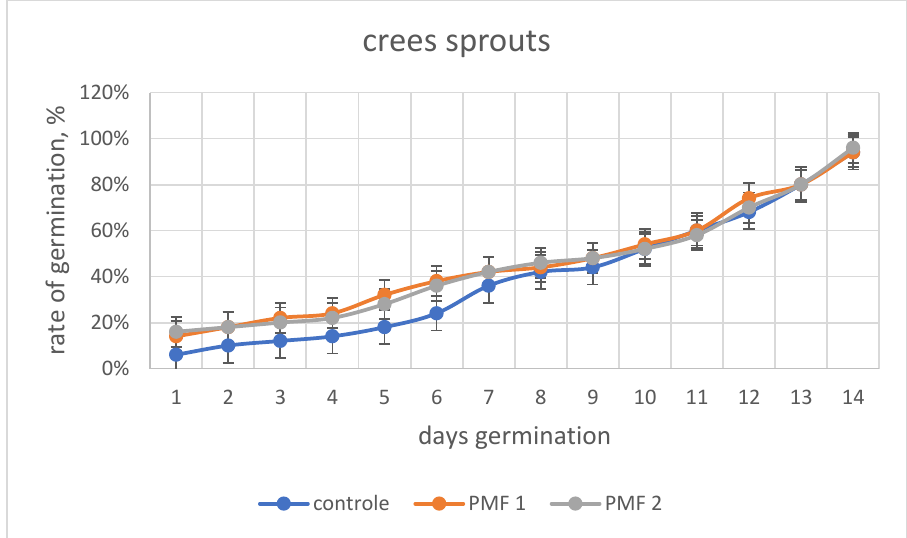
Figure 5. Cress sprout germination dynamics for the control sample and for magnetic field 1 (PMF 1 – 100 µT and 100 Hz) and magnetic field 2 (PMF 2 –100 µT and 200 Hz), mean standard error α = 0.05.